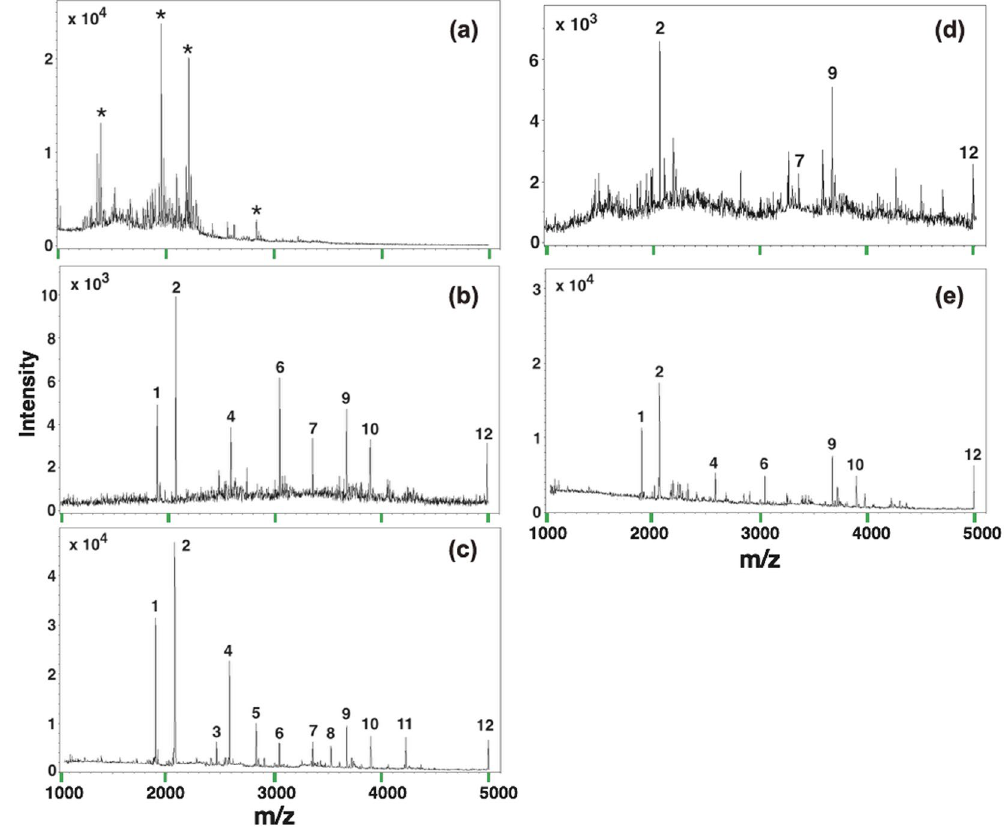
Figure 6. MALDI-TOF/TOF mass spectra of the tryptic digest mixture of HRP and MYO (n/n = 1/100): ( a ) without enrichment, ( b ) after enrichment by B-Fe 3 O 4 @mTiO 2 microspheres, ( c ) after enrichment by B-Fe 3 O 4 @ mTiO 2 microspheres and PMMA nanobeads, ( d ) after enrichment by commercial SiMAG-boronic acid, and ( e ) after enrichment by SiMAG-boronic acid and PMMA nanobeads. Note that asterisk marks label peaks of nonglycopeptide, and Arabic numbers label peaks of